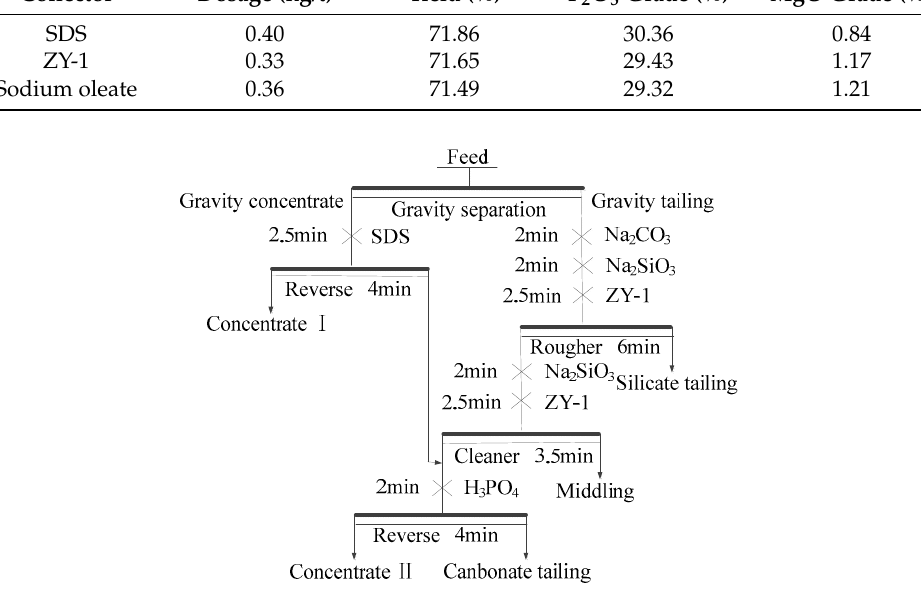
Figure 6. Improved gravity-flotation combination process.